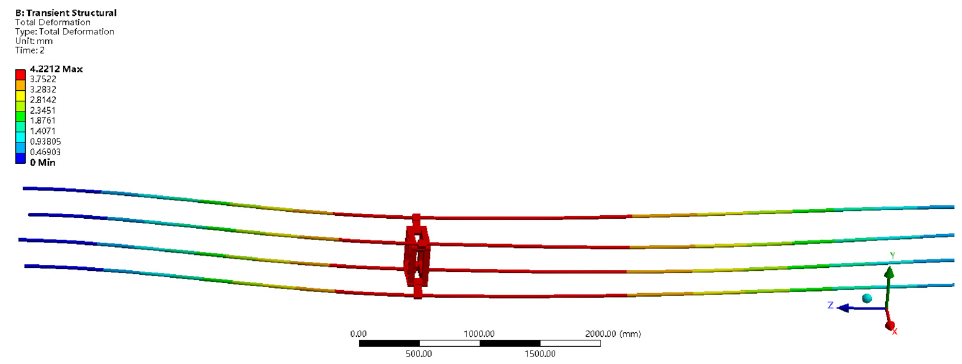
Figure 6. The initial galloping displacement cloud map of the original spacer bar.